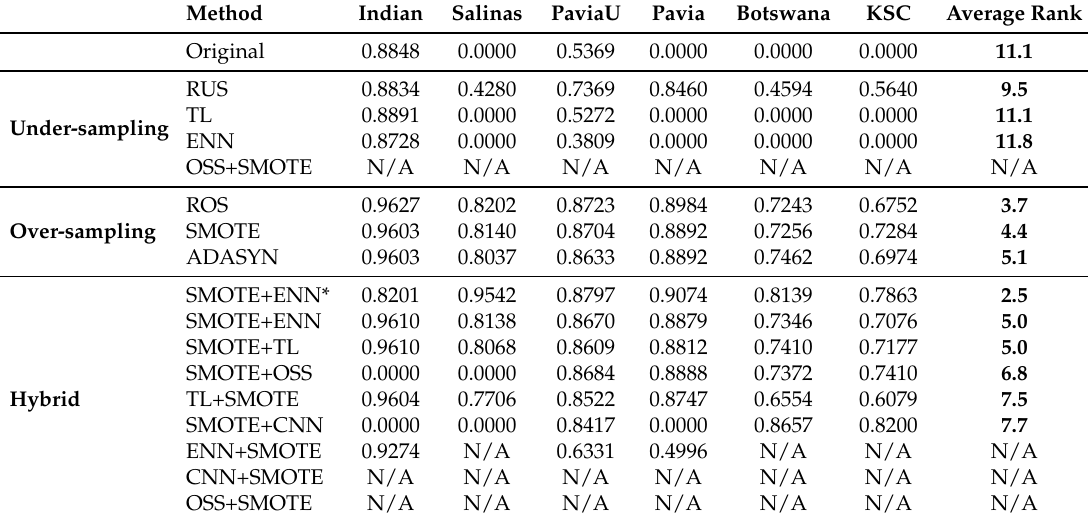
Table 3. DL-MLP performance using the g-mean (Equation (5)) as measure. Values presented correspond to averages of ten different initializations of the neural network